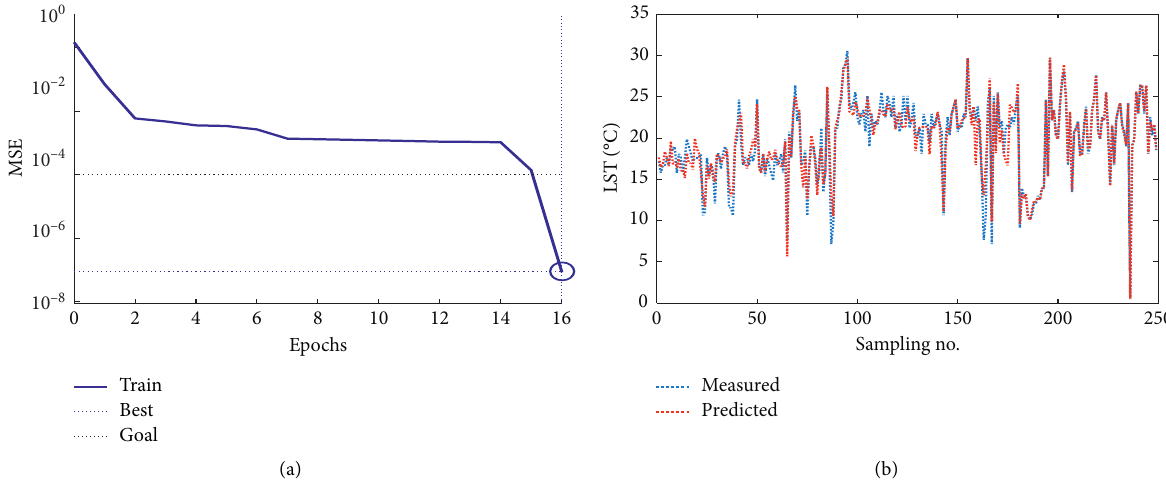
Figure 11: (a) The epochs model performance and (b) DENFIS model performance for the training